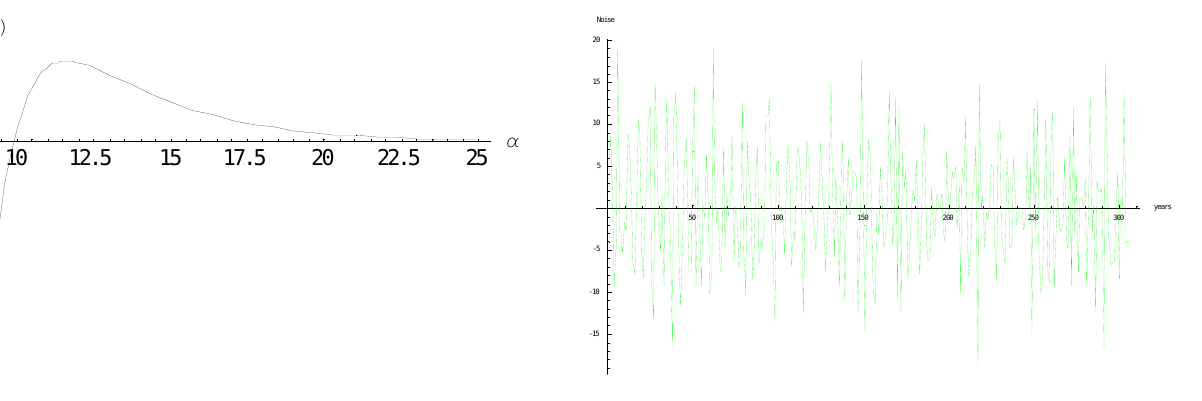
Fig. 5. Residuals ξ ( t) between observed and modelled annual sunspot numbers behave largely as Gaussian